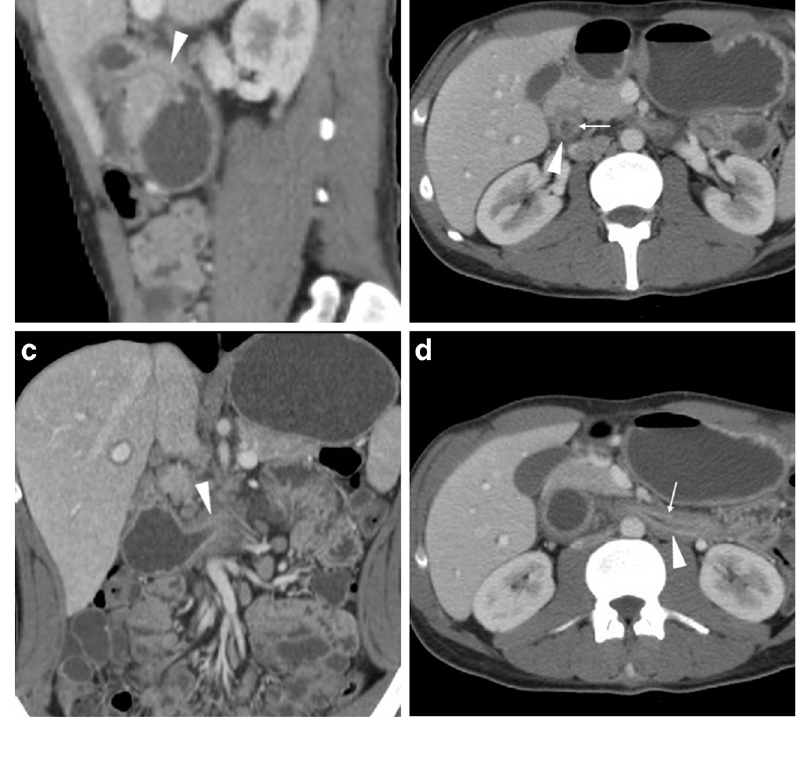
Fig. 15 A 62-year-old diabetic male with recurrent metabolic decompensation and recent foot infection suffered from vomiting, abdominal pain and distension. With negative endoscopic findings, diabetic gastroparesis was diagnosed and treated with parenteral nutrition and peristaltic